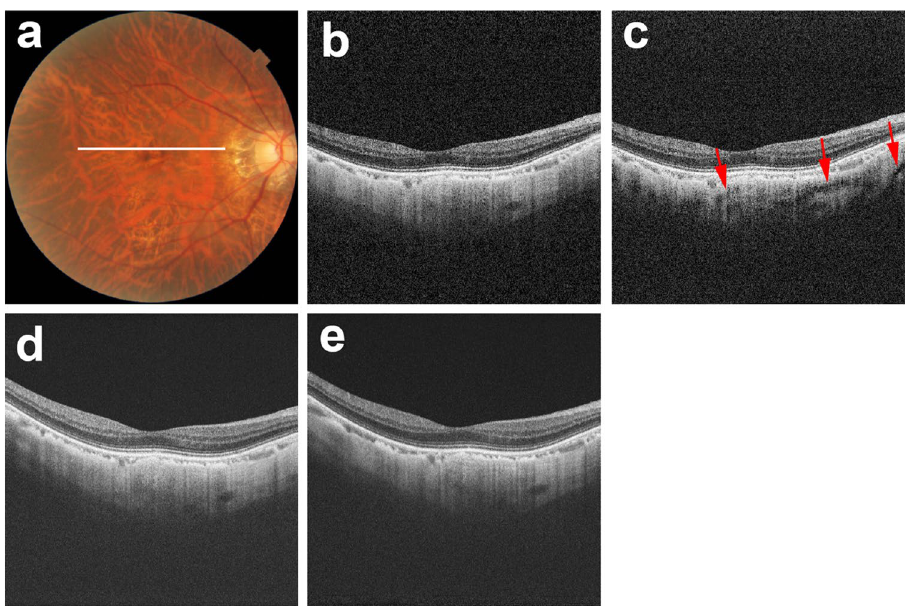
Figure 3. Scleral vessel artifacts in a polarization-dependent OCT image. The right eye of a 66-year-old woman with pathologic myopia is shown. White line in color fundus image ( a ) indicates the scan line for PD-OCT images and commercial OCT B-scan images ( b – e ). Polarization-dependent OCT B-scan image ( c ) shows scleral vessel artifacts (red arrows). No scleral vessel artifacts are present in a polarization-independent OCT B-scan image ( b ) or in two repeated commercial OCT B-scan images ( d , e